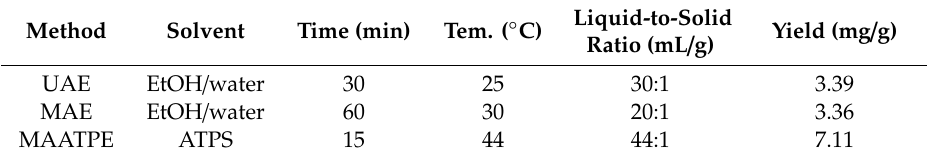
Table 3. Comparison of MAATPE with conventional methods with regard to the extraction yield of